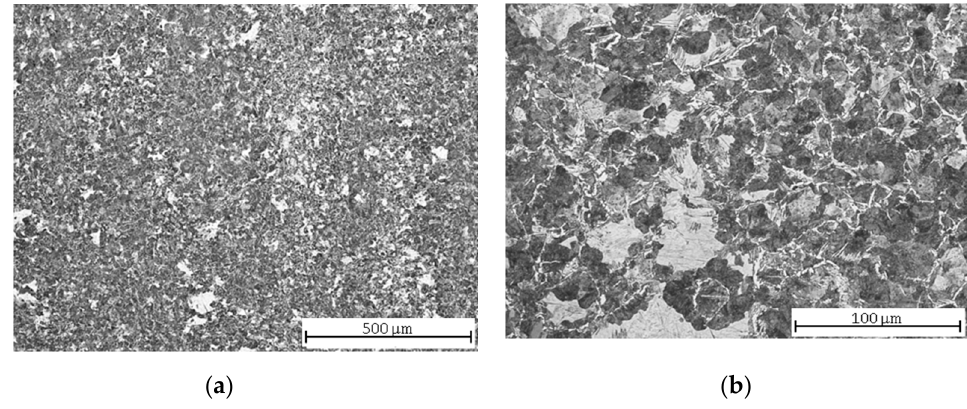
Figure 3. C45 steel microstructures after quenching: ( a ) central part; ( b ) detail.